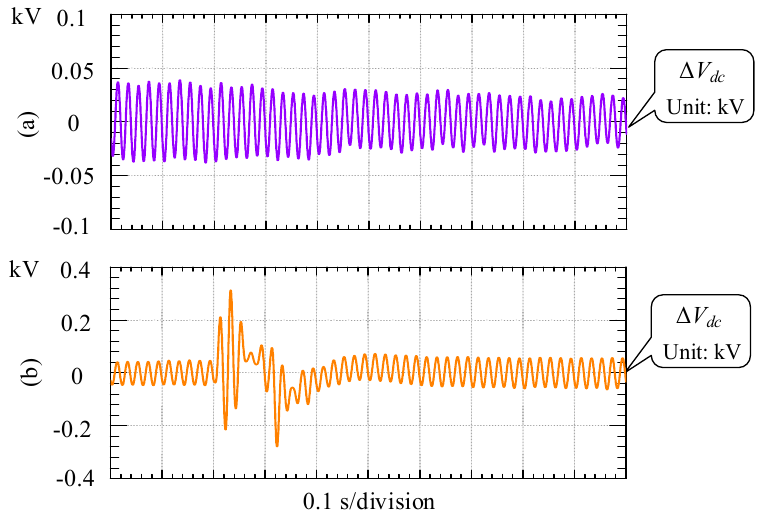
Figure 20. Upper and lower capacitor voltage difference ( a ) without the low voltage period and ( b ) with the low voltage period from t = 1.2 s–1.3 s.